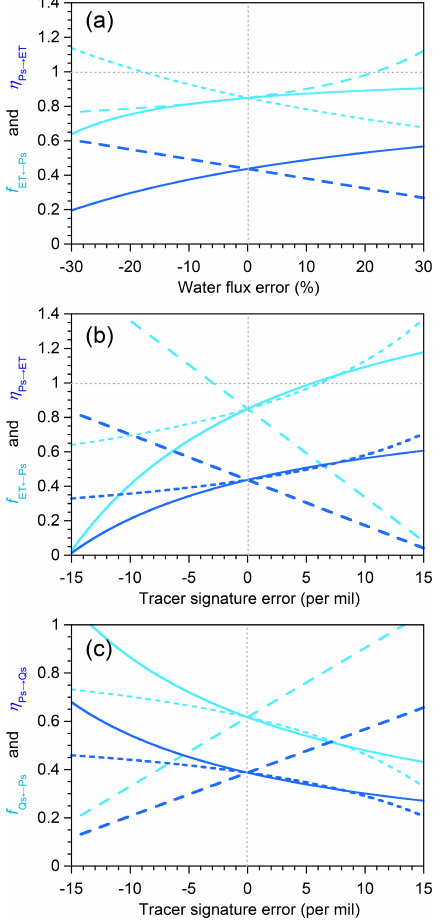
Figure 12. Sensitivity of end-member splitting fractions to mea- surement errors in water fluxes (a) and tracer signatures (b, c) . Light blue curves show variations in the fraction of evapotranspira- tion ( f ET ← P ; a, b ) and summer streamflow ( f Q ; c ) that origi- s s ← P s nates as summer precipitation. Dark blue curves show variations in the fraction of summer precipitation that eventually evapotranspires ( η P ; a, b ) or becomes summer streamflow ( η P ; c ). Solid s → ET s → Q s (b, c) . Dotted curves curves show effects of errors in P s (a) and δ P s (b, c) . Dashed curves show show effects of errors in P w (a) and δ P w (c) . Curves are calculated effects of errors in Q (a) , δ Q (b) , and δ Q s using Eqs. (11), (18), (22), and (25), using input values from Fig. 4, adjusted as shown on the x axis of each